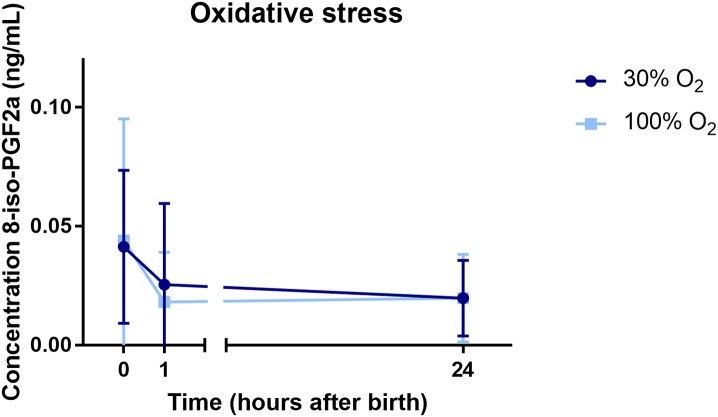
The concentration of 8-iso-prostaglandin F2α (8-iso-PGF2α) in the first 24 h after birth.